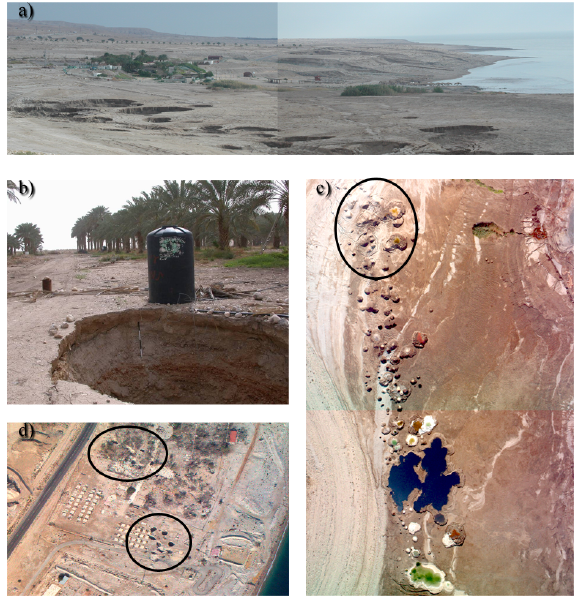
Figure 1. Collapse sinkholes along the Dead Sea